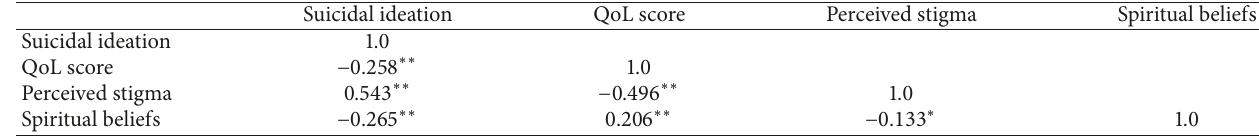
Table 2: The correlations between suicidal ideation and QoL, perceived stigma, and spiritual